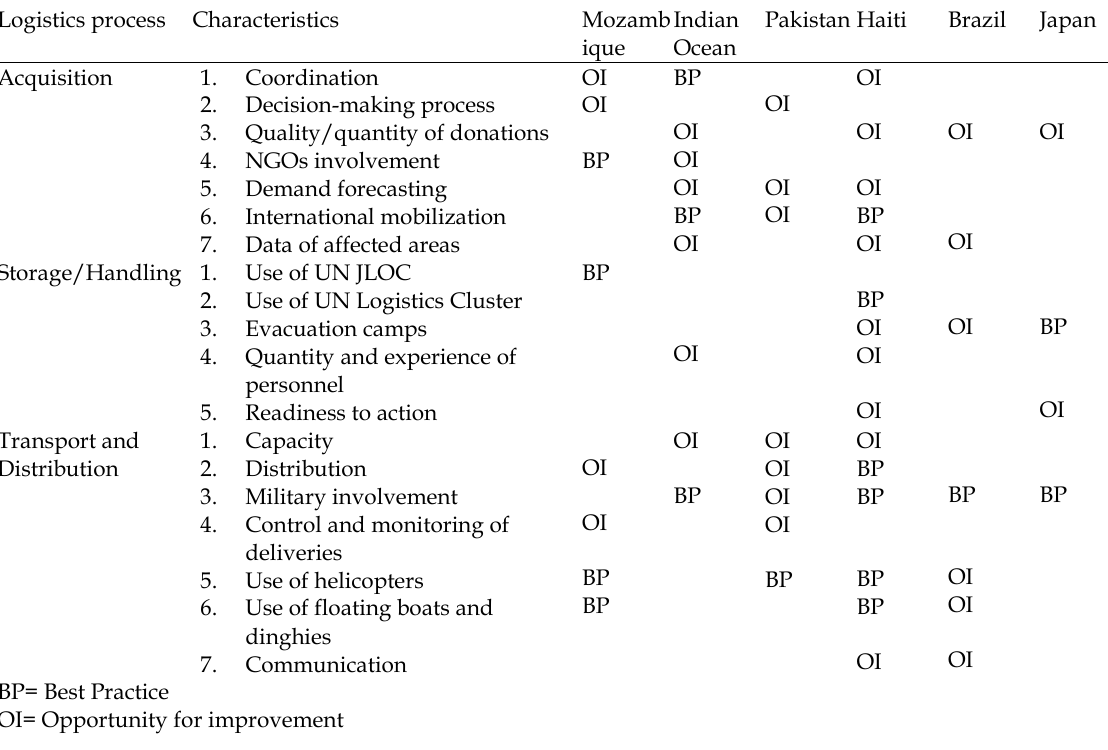
Table 3. Opportunities for improvement and research according to the stages of humanitarian